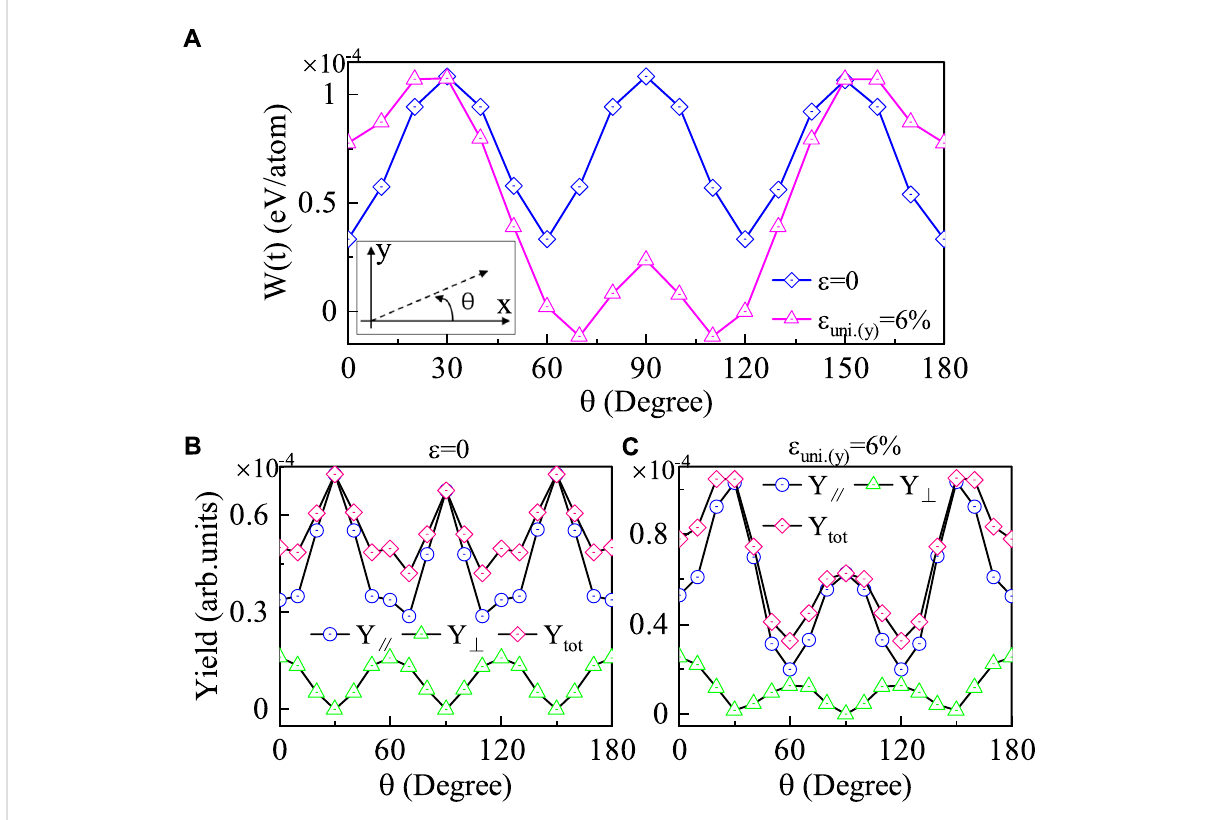
FIGURE 5 (A) Thecalculatedenergyabsorption peratomofthemonolayerhBNas afunctionofthelaserrotationangleunderstretchingpercentsof ε =0 and ε uni.(y) = 6%. The inset shows the angle of the laser in-plane polarization. The laser fi eld is fi rst polarized in the x direction and then rotated counterclockwise. The harmonic yield as a function of the laser rotation for cases of ε = 0 (B) and ε uni.(y) = 6% (C) . The HHG yield component that parallel or perpendicular to the linearly polarized fi eld is denoted by circle and triangle symbols, respectively. Cubic symbols are the total harmonic